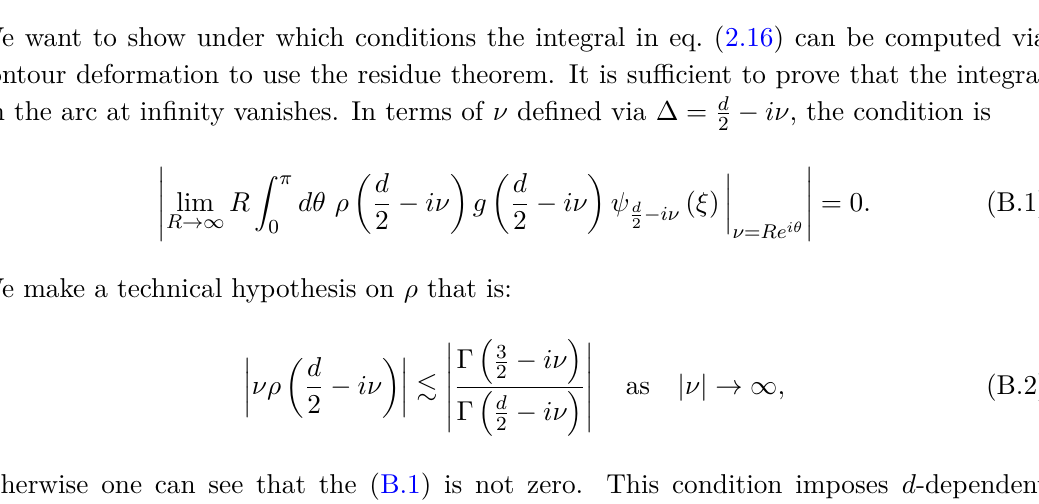
Figure 3 . Complex plot of Arg highlight the